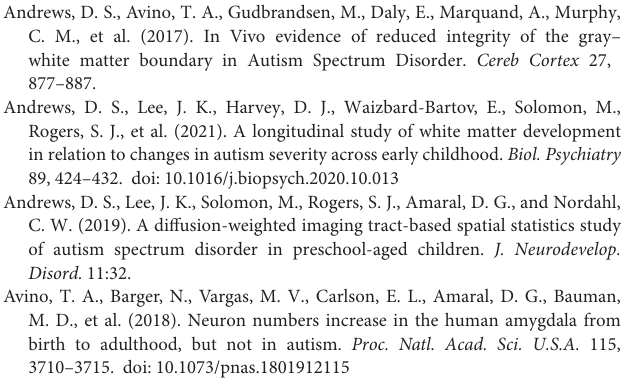
Supplementary Figure 2 | (A) Clusters with a significant effect of time on gray-white matter contrast (GWC) in the HR-TD group. Clusters with cluster-wise P -value (CWP) < 0.05 only are displayed. Color code corresponds to P -value of the vertex with the maximal P -value (Pvm) of each cluster. (B) On the right are plotted for each hemisphere the individual GWC rates of change ( (cid:49) GWC) within each significant cluster (one per hemisphere). We found no significant difference between both clusters (paired t -test, p = 0.15). Supplementary Figure 3 | Results displayed on Figure 4 (Association between GWC at age 12–24 months and symptom severity at 18 months of age) with individual GWC values displayed for each significant cluster in function of ADOS calibrated severity score (CSS) (upper-side graphs), diagnostic outcome group (left down-side graphs) and HR-ASD subgroups (right down-side graphs). (A) Results for clusters with significant correlation between GWC and 18-mo ADOS CSS. (B) Clusters with significant correlation between GWC and 36-mo ADOS CSS. ∗ p < 0.05, ∗∗ p < 0.01, and ∗∗∗ p < 0.001. Supplementary Figure 4 | Results displayed on Figure 5 (Association between symptom severity at 18 months of age and GWC rate of change ( (cid:49) GWC) between 12 and 24 months of age) with individual (cid:49) GWC displayed for each cluster in function ADOS calibrated severity score (CSS) (upper-side graph), diagnostic outcome group (left down-side graphs) and HR-ASD subgroups (right down-side graphs). ∗ p < 0.05, ∗∗ p < 0.01, and ∗∗∗ p < 0.001. Supplementary Figure 5 | Association between cortical thickness at age 12–24 months and diagnostic outcome at 36 months of age (HR-ASD or HR-TD). The single cluster with significantly smaller CT in HR-ASD compared to HR-TD (CWP < 0.05) is displayed. We found no significant cluster in the right hemisphere. Color code corresponds to P -value of the vertex with maximal P -value (Pvm) of the displayed cluster. On the right, individual CT -values are displayed in function of diagnosis outcome for the displayed cluster. ∗ p < 0.05. CWP, cluster-wise P -value. Supplementary Figure 6 | Results of supplementary analysis comparing LR-TD with HR-ASD (A) and LR-TD with HR-TD (B) . Color code corresponds to P -value of the vertex with maximal P -value (Pvm) of the displayed clusters. On the graphs, individual GWC values are displayed in function of diagnosis outcome for the displayed clusters. Supplementary Figure 7 | (A) Effect of time on GWC within LR toddlers with typical development outcomes at 3 years (LR-TD) represented with vertex-wise (cid:49) GWC values mapped on the common FreeSurfer template. (B) Clusters with a significant effect of time on gray-white matter contrast (GWC) in the LR-TD group. Clusters with cluster-wise P -value (CWP) < 0.05 only are displayed. Color code corresponds to P -value of the vertex with the maximal P -value (Pvm) of each cluster. Supplementary Table 1 | Demographic and behavioral information on HR-ASD subgroups (LOA and EOA). P -value of statistical comparison between both